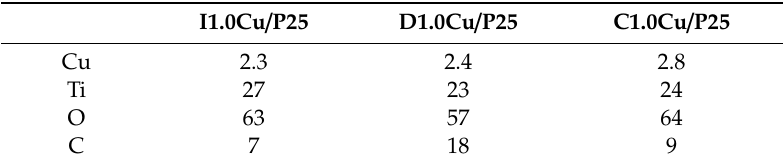
Table 4. Atomic fraction (%) of Cu, Ti, O, and C as obtained by XPS data. Values are rounded o ff to keep the correct number of significant